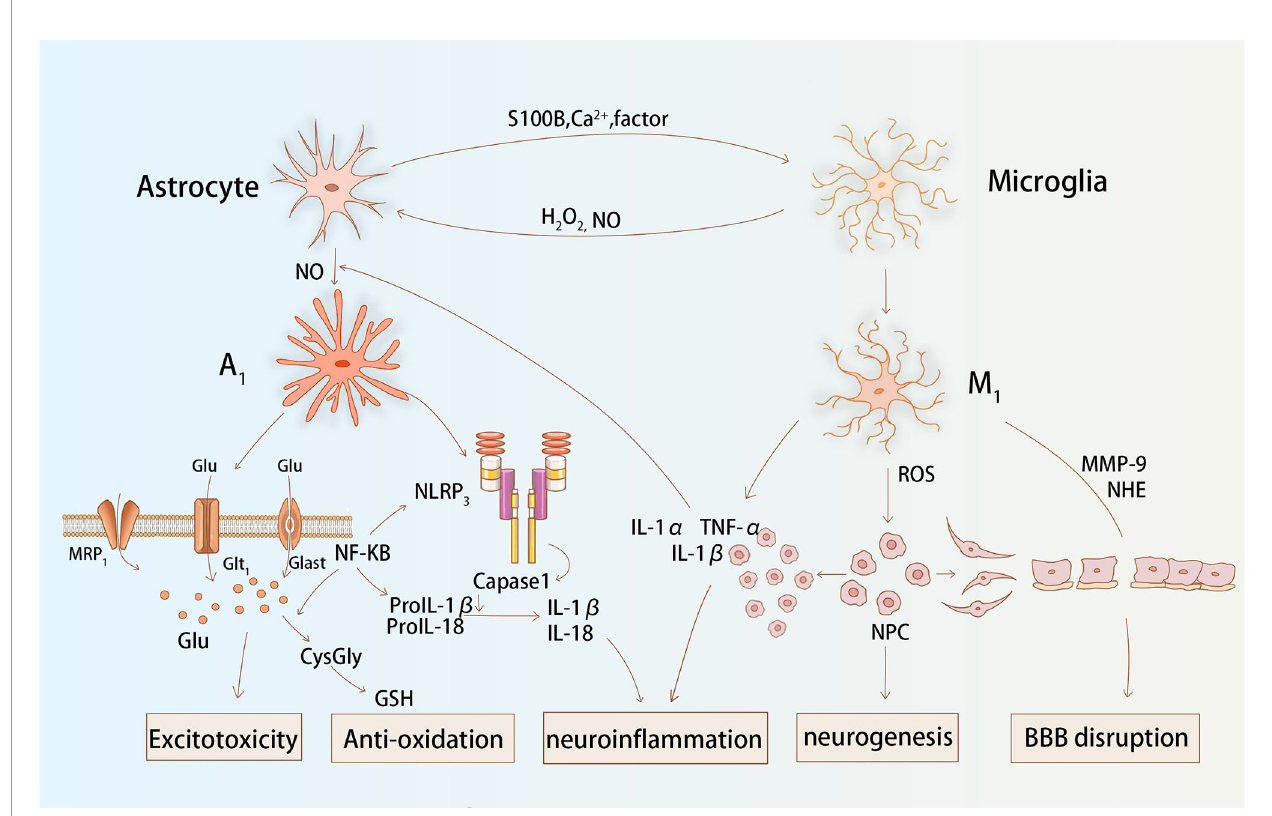
FIGURE 2 | Astrocytes and microglia interact and function together during stroke. Astrocytes release Ca 2+ , S100B, and cytokines that affect the redox state of microglia. The production of H 2 O 2 and NO by microglia facilitates the activation process of astroglial. Glial cells affect glutamate transport, in fl ammatory factor secretion, matrix protease activation, and antioxidant production via ROS, which together cause post-stroke excitotoxicity, neuroin fl ammation, BBB destruction, and